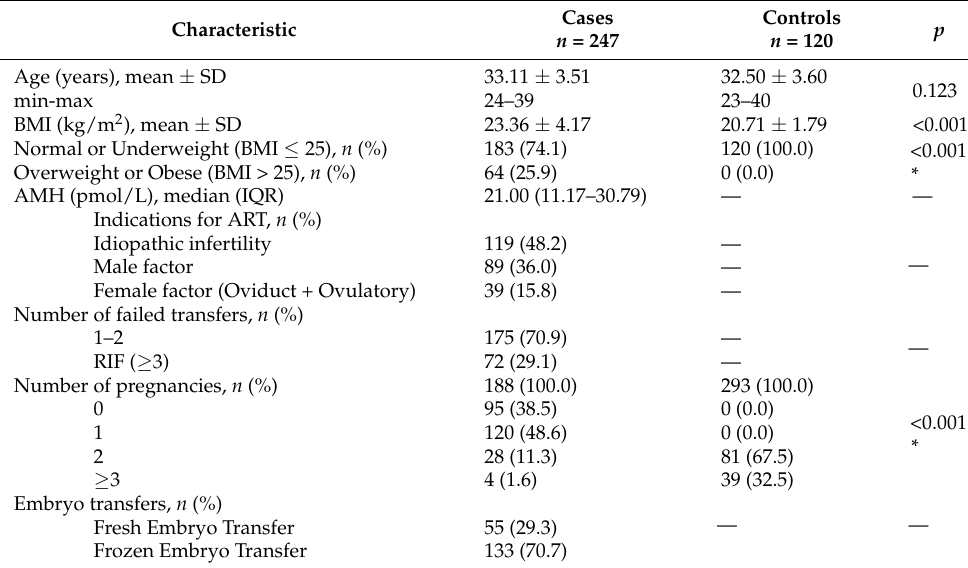
Table 1. Clinical characteristics of infertile women and controls.